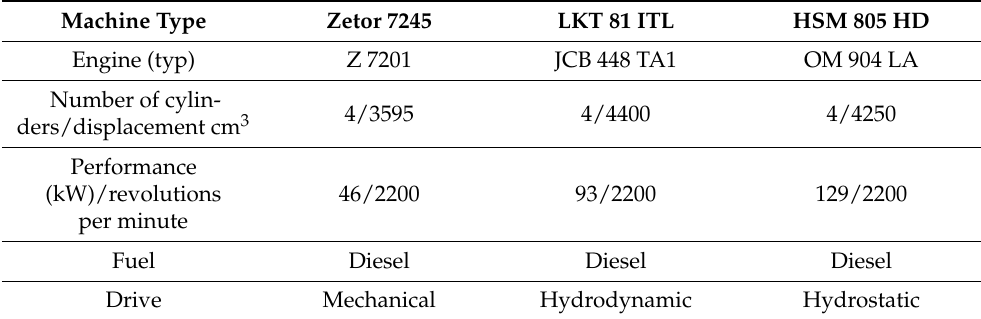
Table 2. Technical parameters of the observed